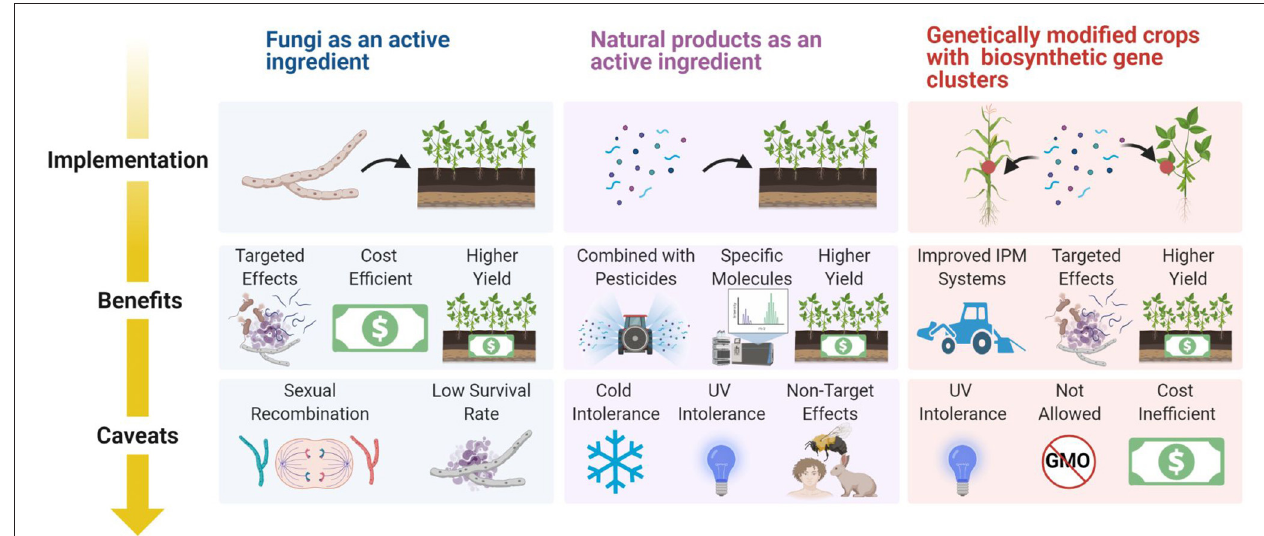
FIGURE 13 | Considerations for how to introduce biological products from Trichoderma into field applications.